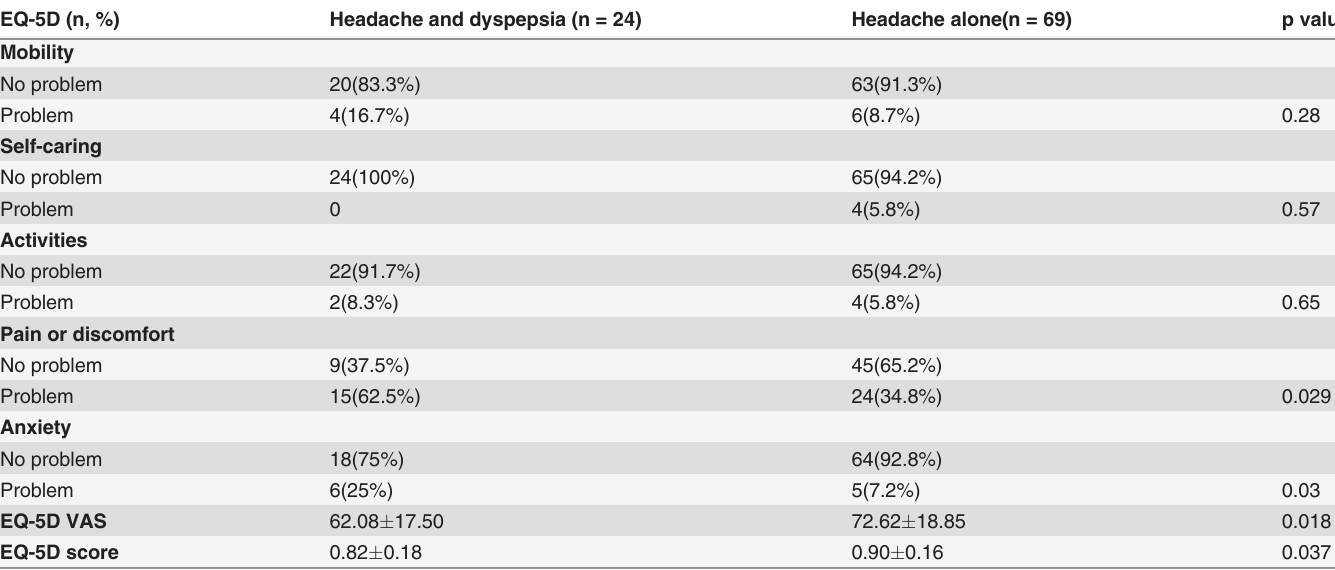
Table 4. HRQOL differences between headache with and without